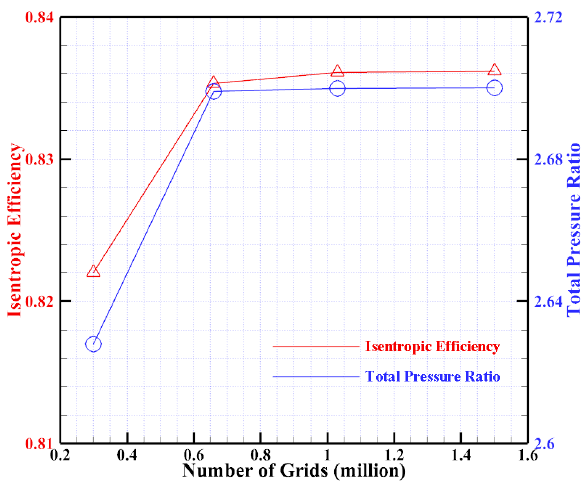
Figure 4. Grid independence verification.